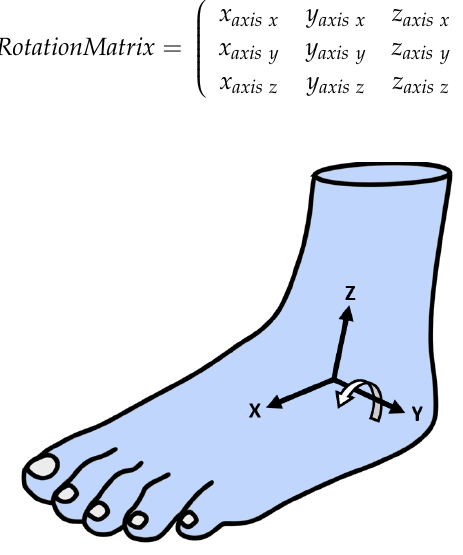
Figure 6. Local axis of the left foot .